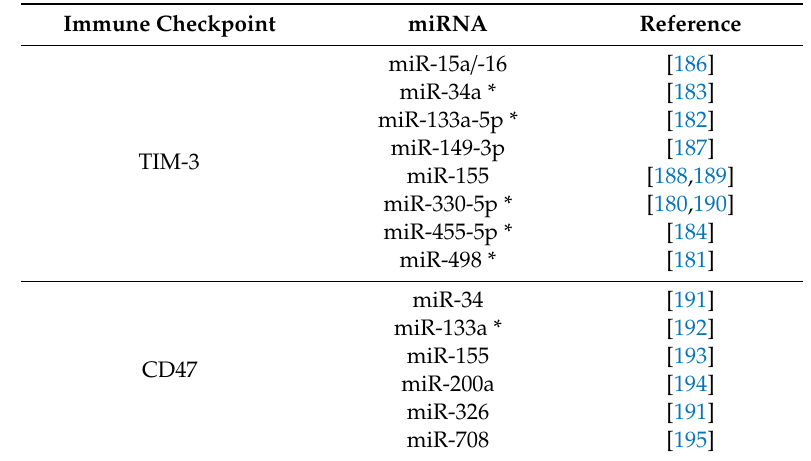
Table 5. miRNAs Identified to Target the Checkpoint Molecules TIM-3 and